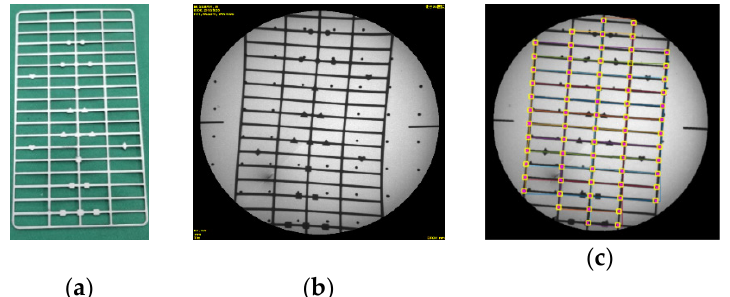
Figure 9. Image rectification test: ( a ) Test grid plate; ( b ) Raw X-Ray image of test plate; ( c ) Rectified Images. “×” represented the position of the grid points of the test plate in the raw image, “——” represented the grid distribution of the test plate in the raw image and □ represented the ideal position of the test plate.